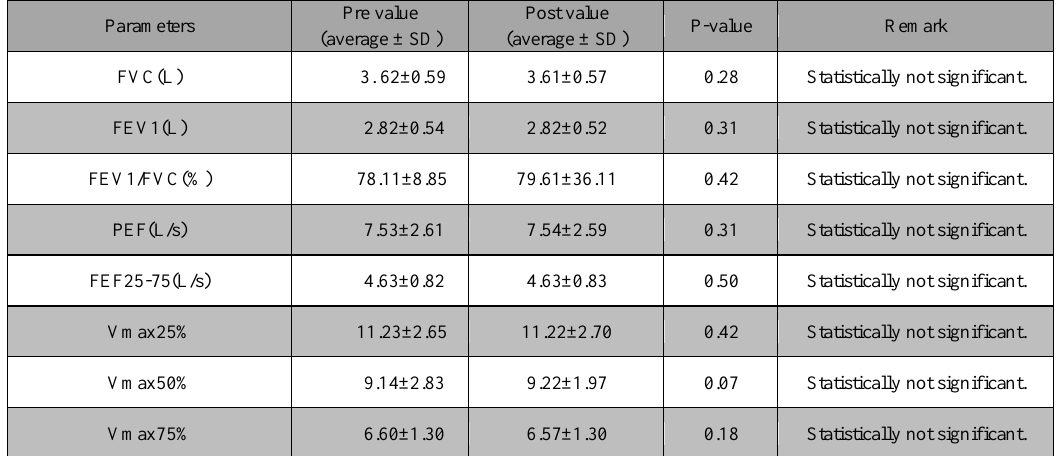
Table 2. PFT values in control group subjects.